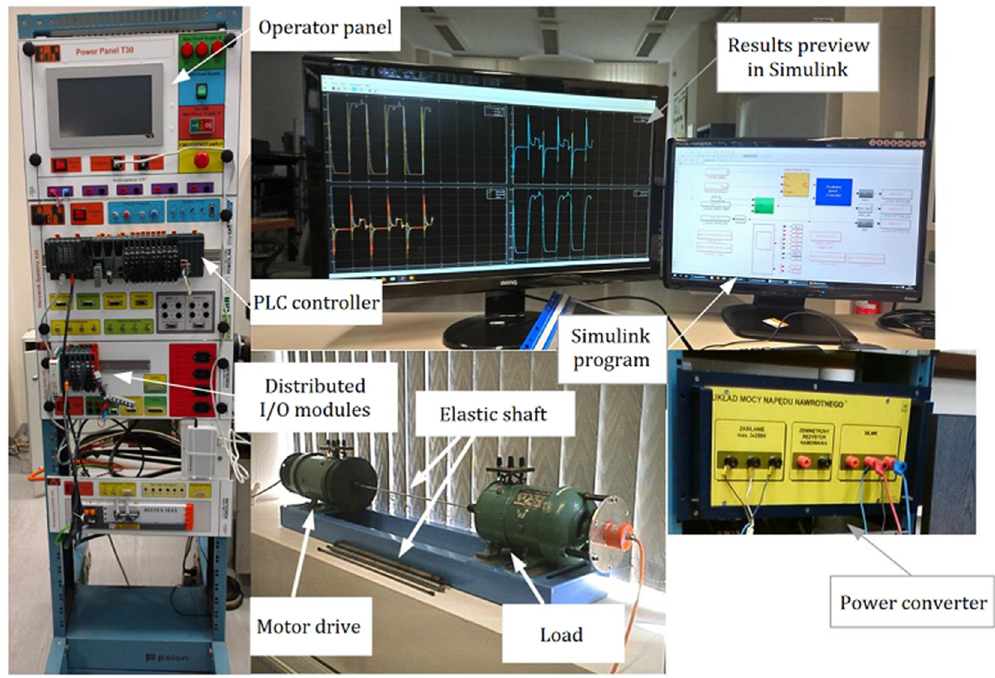
Figure 9. Full view of the experimental setup.